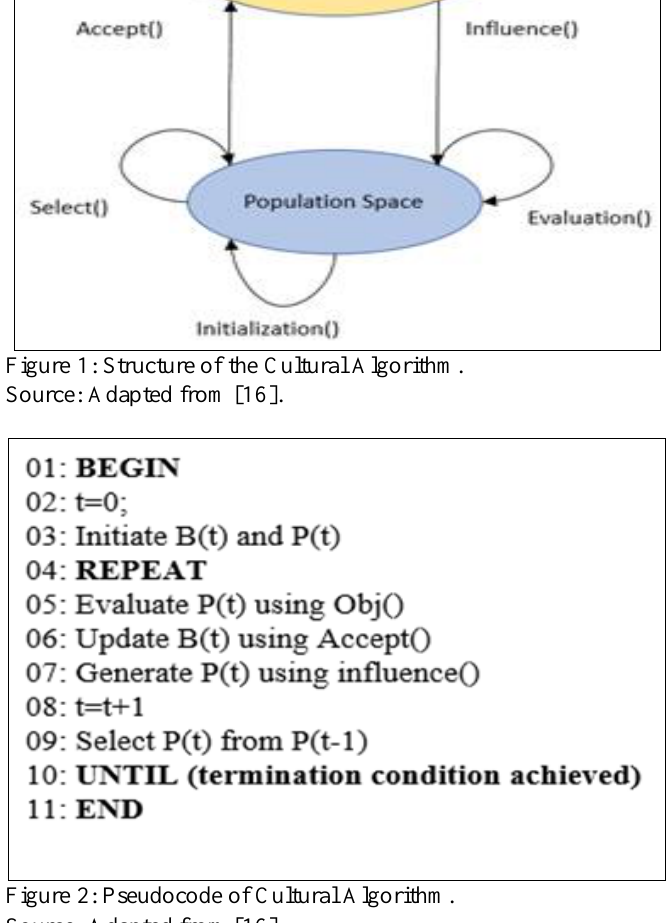
Figure 2: Pseudocode of Cultural Algorithm. Source: Adapted from